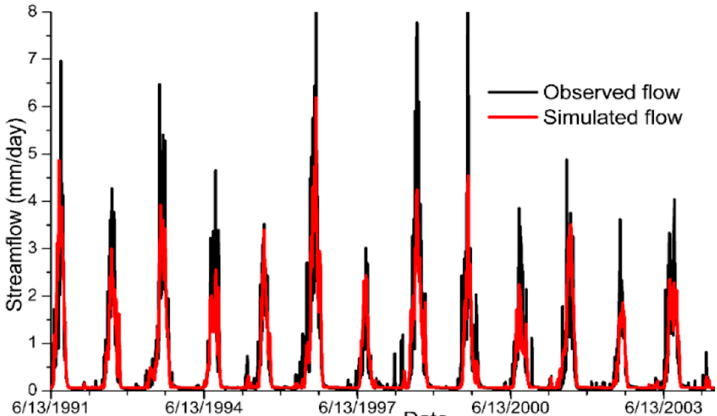
Figure 4. Comparison of simulated and observed streamflow for the calibration period (1991–2004).